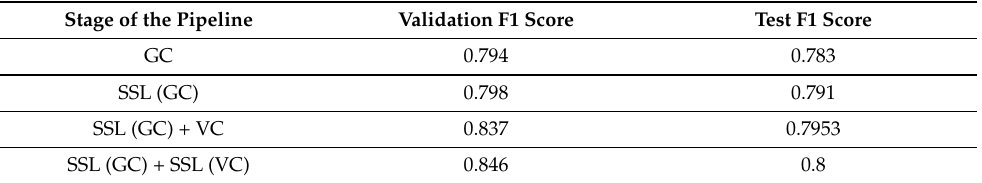
Table 13. A comparison of the F1 scores produced at different stages of the 2020 pipeline using a four-fold cross-validation scheme for the SHL-Validation set and the official SHL-Test data. The abbreviations used in the table are: GC—General classifier, SSL (X)—classifier X trained using semi-supervised learning, VC—vehicle